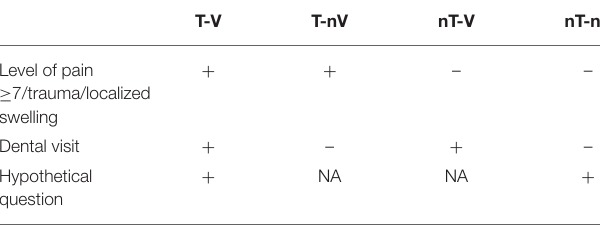
TABLE 1 | Criteria for classification of participants. T-V T-nV nT-V